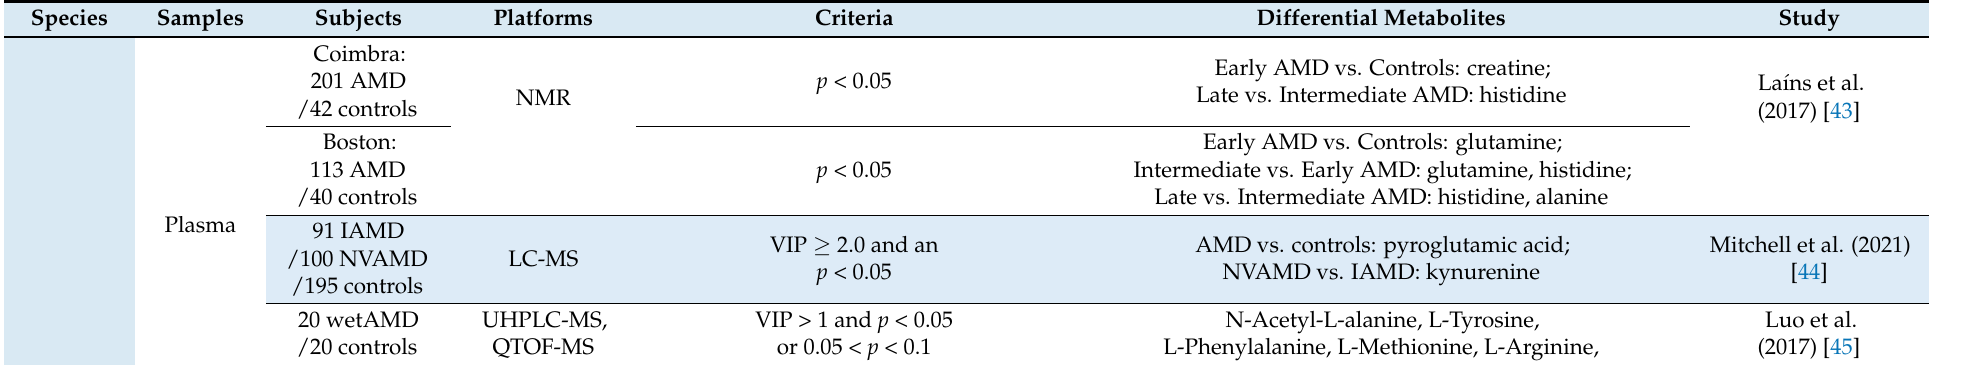
Table 2. Summary of amino acids in age-related macular degeneration based on metabolomics